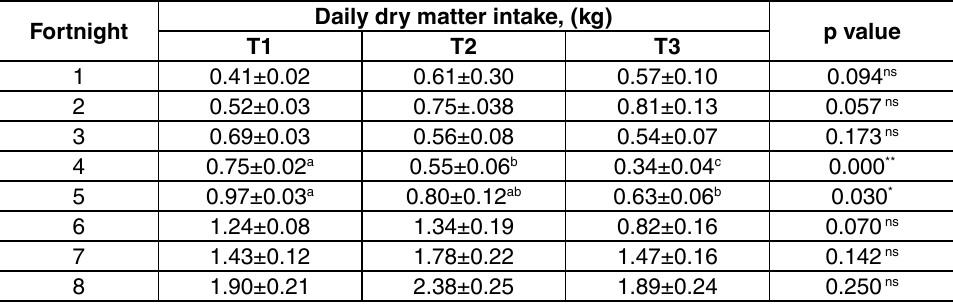
table 4. Fortnightly average total daily dry matter intake 1 of the calves maintained on the